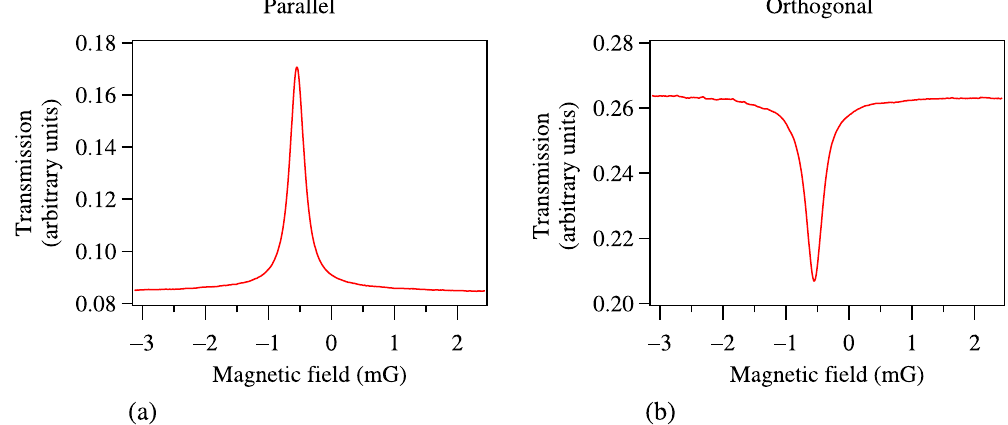
Figure 5. Probe transmission verses longitudinal B field. ( a ) Hanle EIT when probe and control beams have parallel circular polarizations. ( b ) Hanle EIA when probe and control beams have orthogonal circular polarizations.